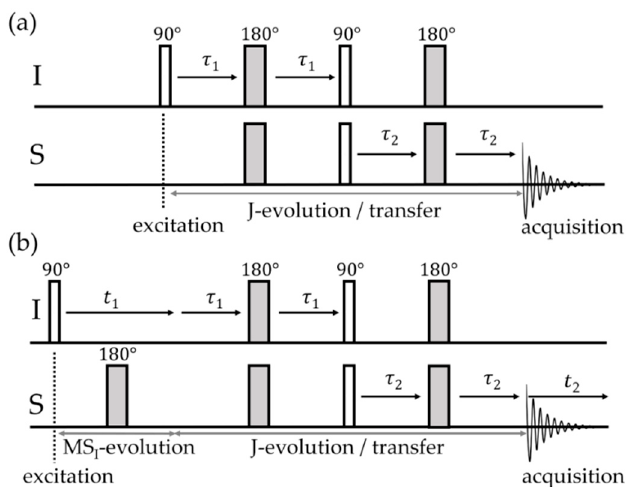
Figure 9. One-dimensional (1D) ( a ) and 2D ( b ) refocused insensitive nuclei enhanced by polarization transfer (INEPT) experiment used for polarization transfer developed via J-coupling to detect heteronuclear correlations.